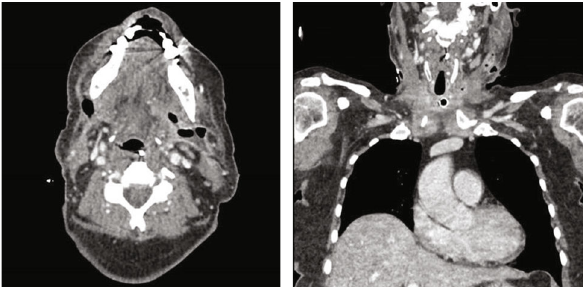
Figure 8: Final CT neck and chest 01/03/2021.